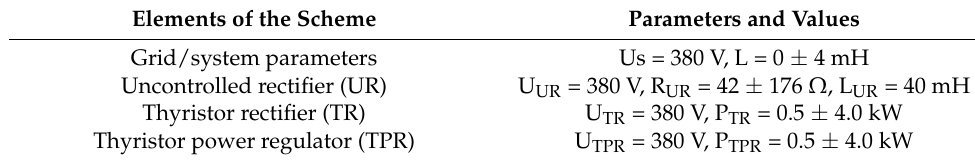
Figure 1. Schematic of the laboratory test bench. The electrical load parameters are presented in Table 1. Table 1. The parameters of the laboratory equipment.